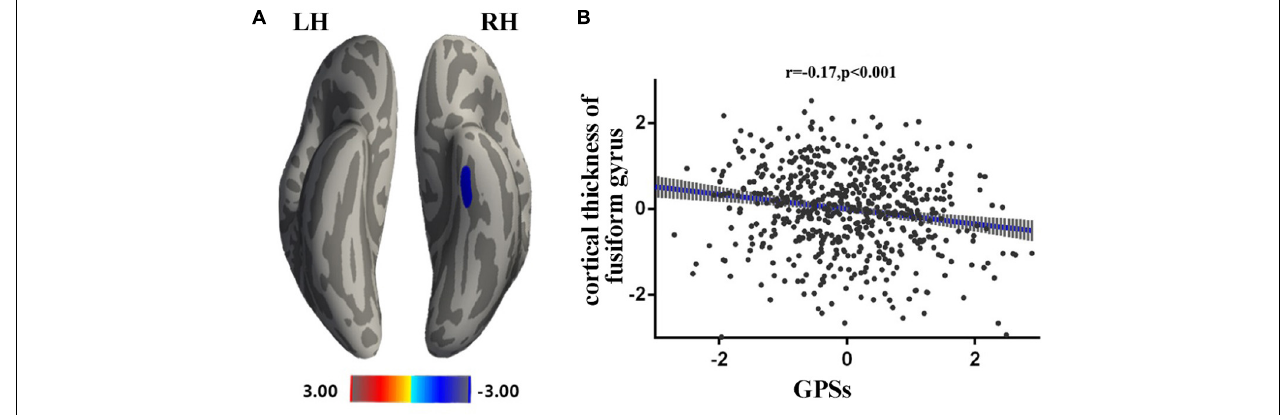
FIGURE 1 | Associations between GPSs and cortical thickness. Statistical parametric maps from multiple linear regression analysis, after controlling for age and sex, demonstrated the correlation of GPSs and cortical thickness of the left fusiform [smooth = 10, Size (mm 2 ) = 281.81, X = –37, Y = –17, Z = –25.30, NVtxs = 579]. The red bar denotes increased correlation between the cortical thickness of the left fusiform and GPSs after controlling for age and sex. The blue bar denotes decreased correlation between the cortical thickness of the left fusiform and GPSs after controlling for age and sex (A) . Scatter plots of the correlations between the significant regions and the GPSs (B) .